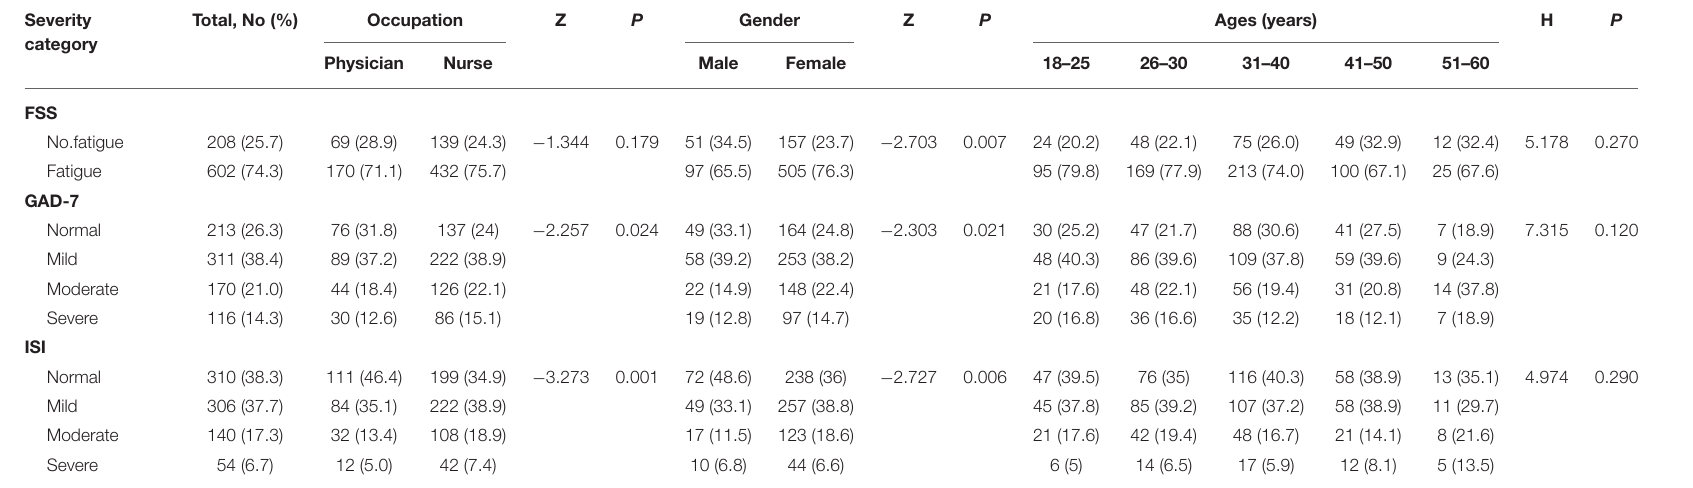
TABLE 2.1 | Severity categories of fatigue, anxiety, and insomnia measurements in total cohort and subgroups.